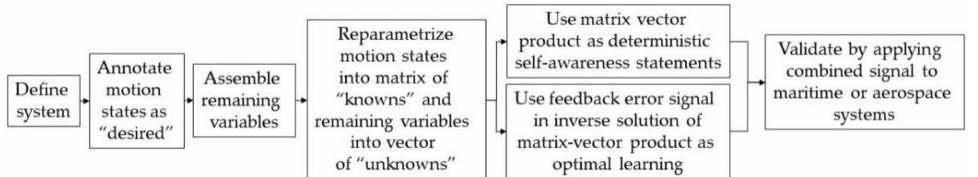
Figure 3. Topology of deterministic artificial intelligence whose depiction applied to UUV system whose actuators are powered by DC motors is in Figure 4.